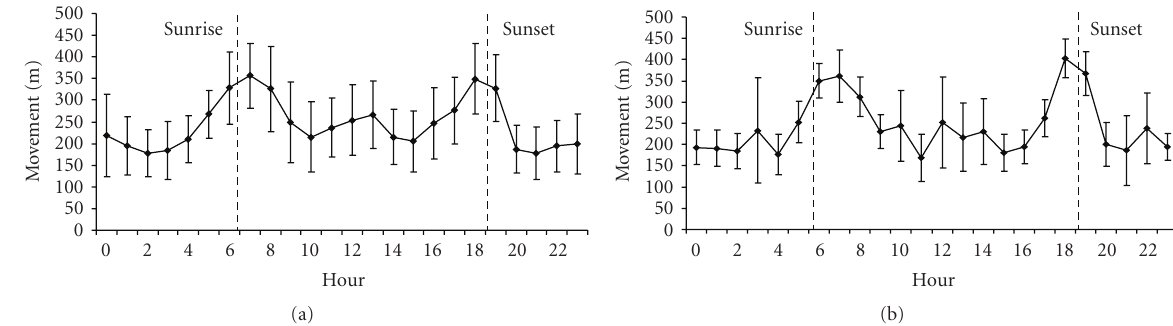
Figure 2: Mean hourly movements (m) of female (a) and male (b) white-tailed deer during spring (March–May).